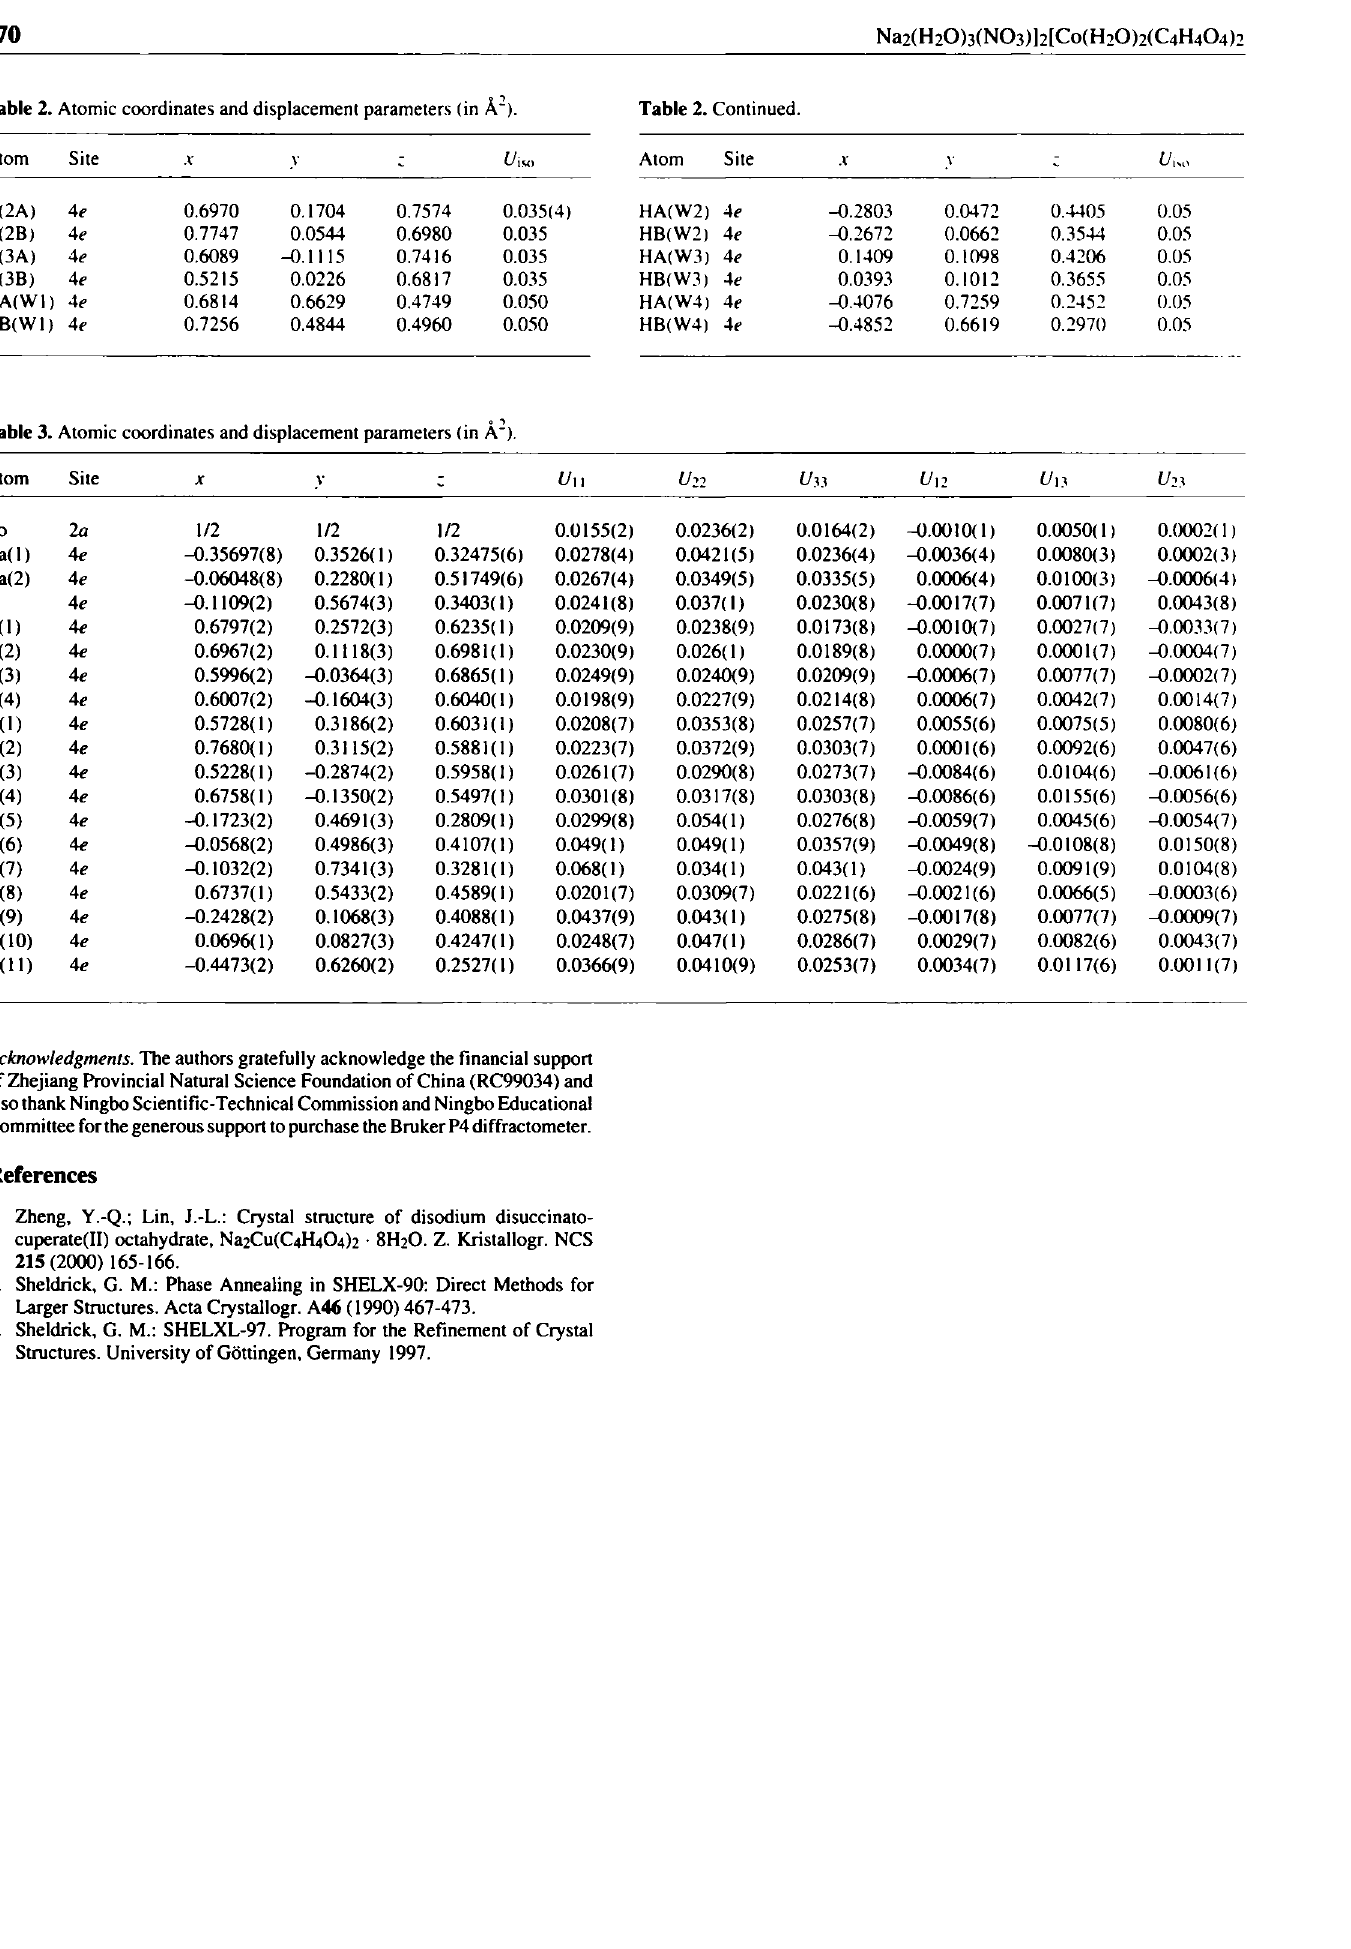
Table 2. Atomic coordinates and displacement parameters (in Ä 2 ). Table 2. Continued.